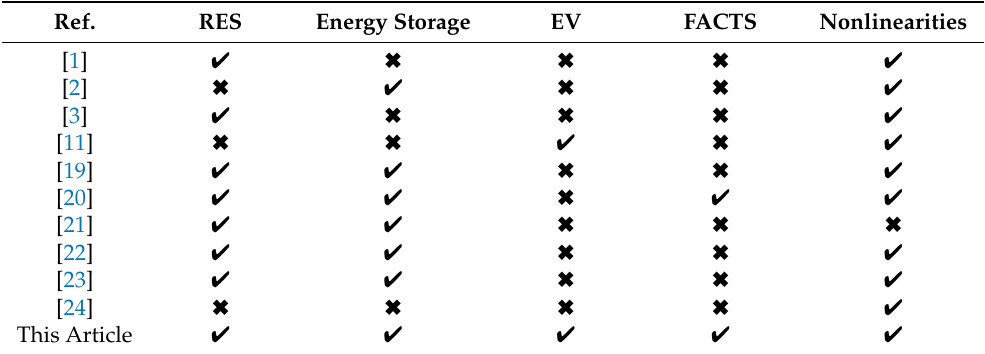
Figure 1. Schematic diagram of sources utilized in the present work. Table 1. Comparative survey of combined AGC and AVR articles with storage, FACTS, RES and EV integration, and nonlinearities.